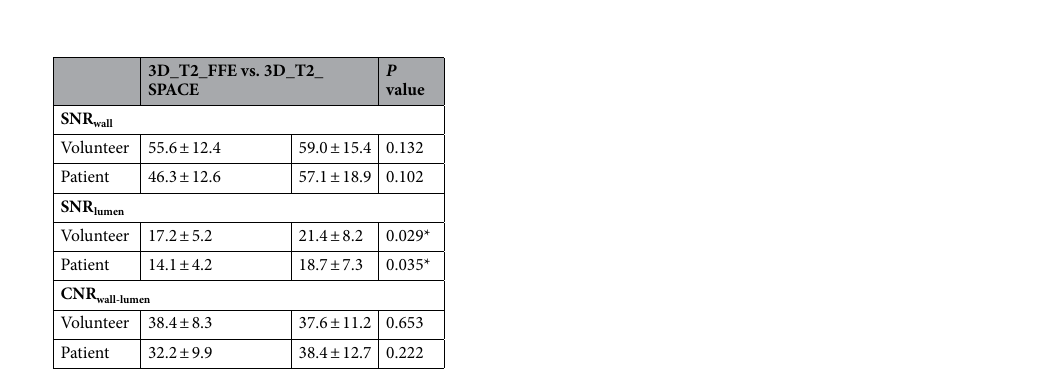
Table 2. Comparison of the SNR and CNR of different structures in the two MRI sequences. SNR, signal-to- noise ratios; CNR, contrast-to-noise ratio; FFE, fast field echo; SPACE, sampling perfection with application- optimized contrast using different flip angle evolutions. *P < 0.05.